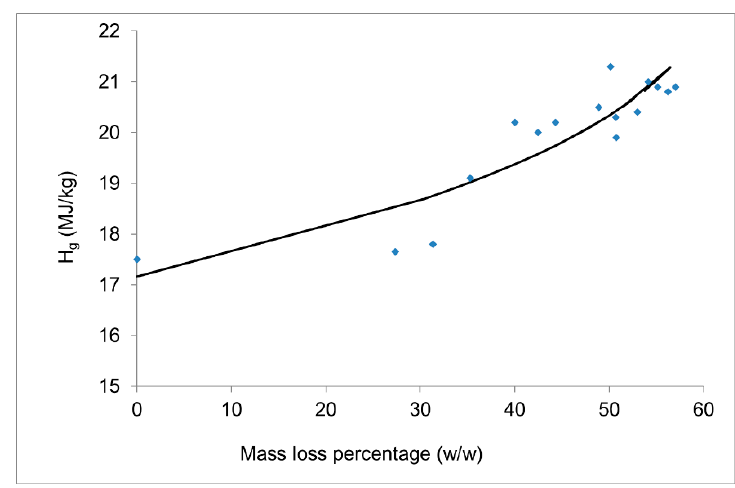
Figure 6. Torrefied barley straw Higher Heating Value of combustion vs. the mass loss percentage.